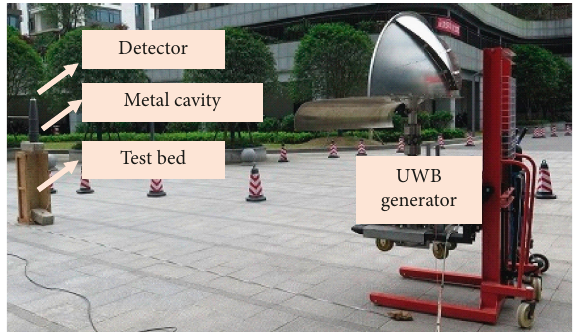
Figure 16: Test setup.